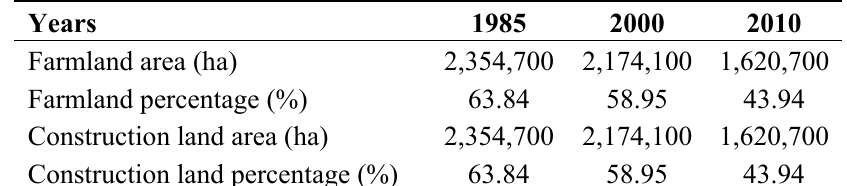
Table 2. The AFOS change